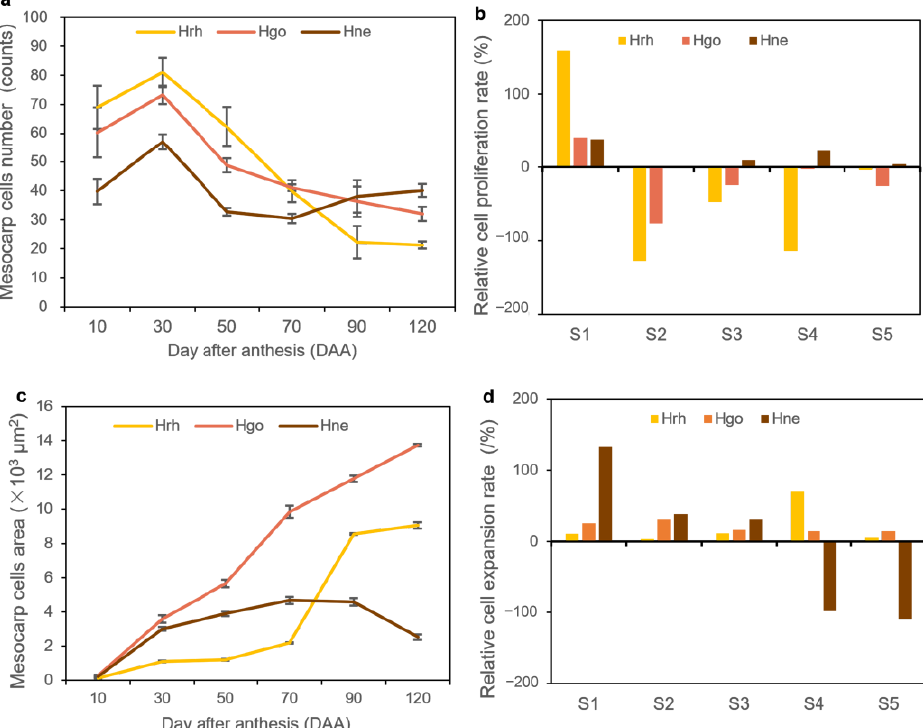
Figure 9. Cell proliferation and cell expansion during fruit morphogenesis of three species of Hip-